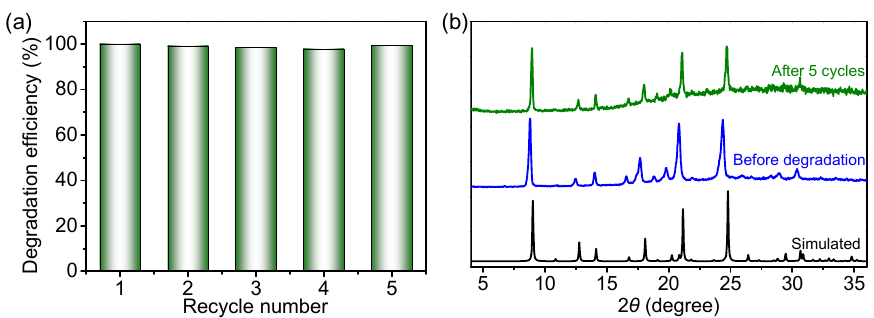
Figure 5. ( a ) Recyclability of COF-300 for BB3 photocatalytic degradation; ( b ) PXRD patterns of COF-300 after cyclic degradation experiments.